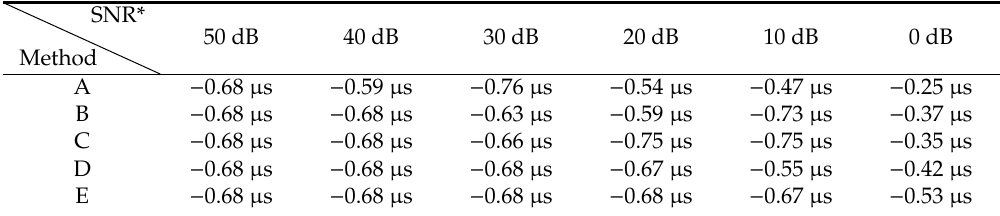
Table 4. The time di ff erence results for the five algorithms with white noise.